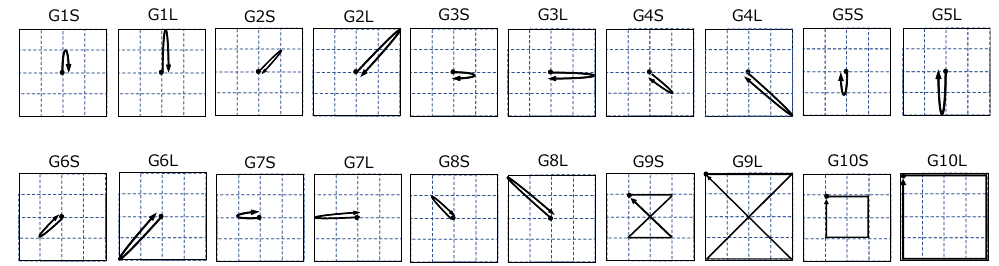
Figure 4. Types of gaze movement. Reprinted with permission from Ref. [25]. Copyright 2021 ACM.